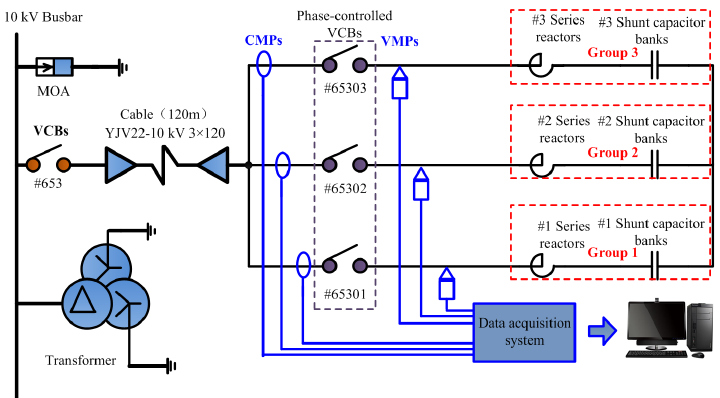
Figure 7. Test circuit of switching 10 kV shunt capacitor banks in a 110 kV substation. Table 1. Parameters of the capacitors and reactors.